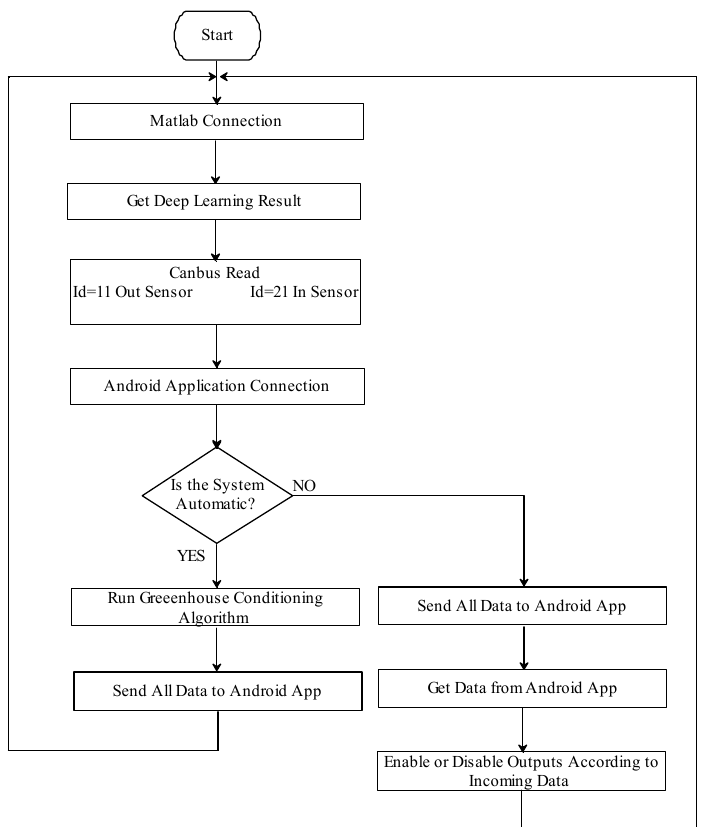
Figure 19. General algorithm of the system.